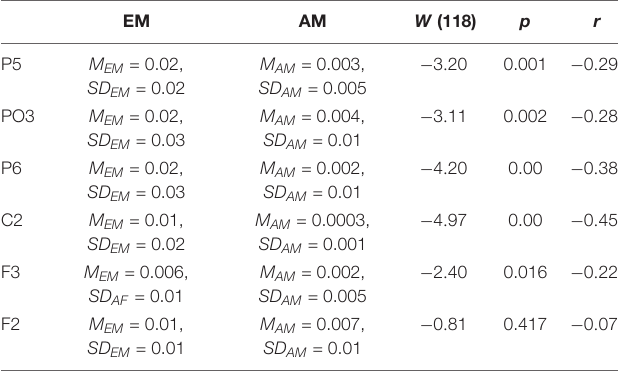
TABLE 5 | Estrogen–male storyteller versus